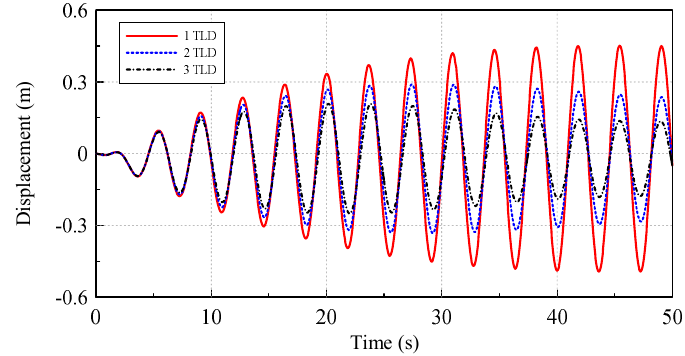
Figure 27. Multiple TLDs on OWT motion reduction and harmonic ground excitation.